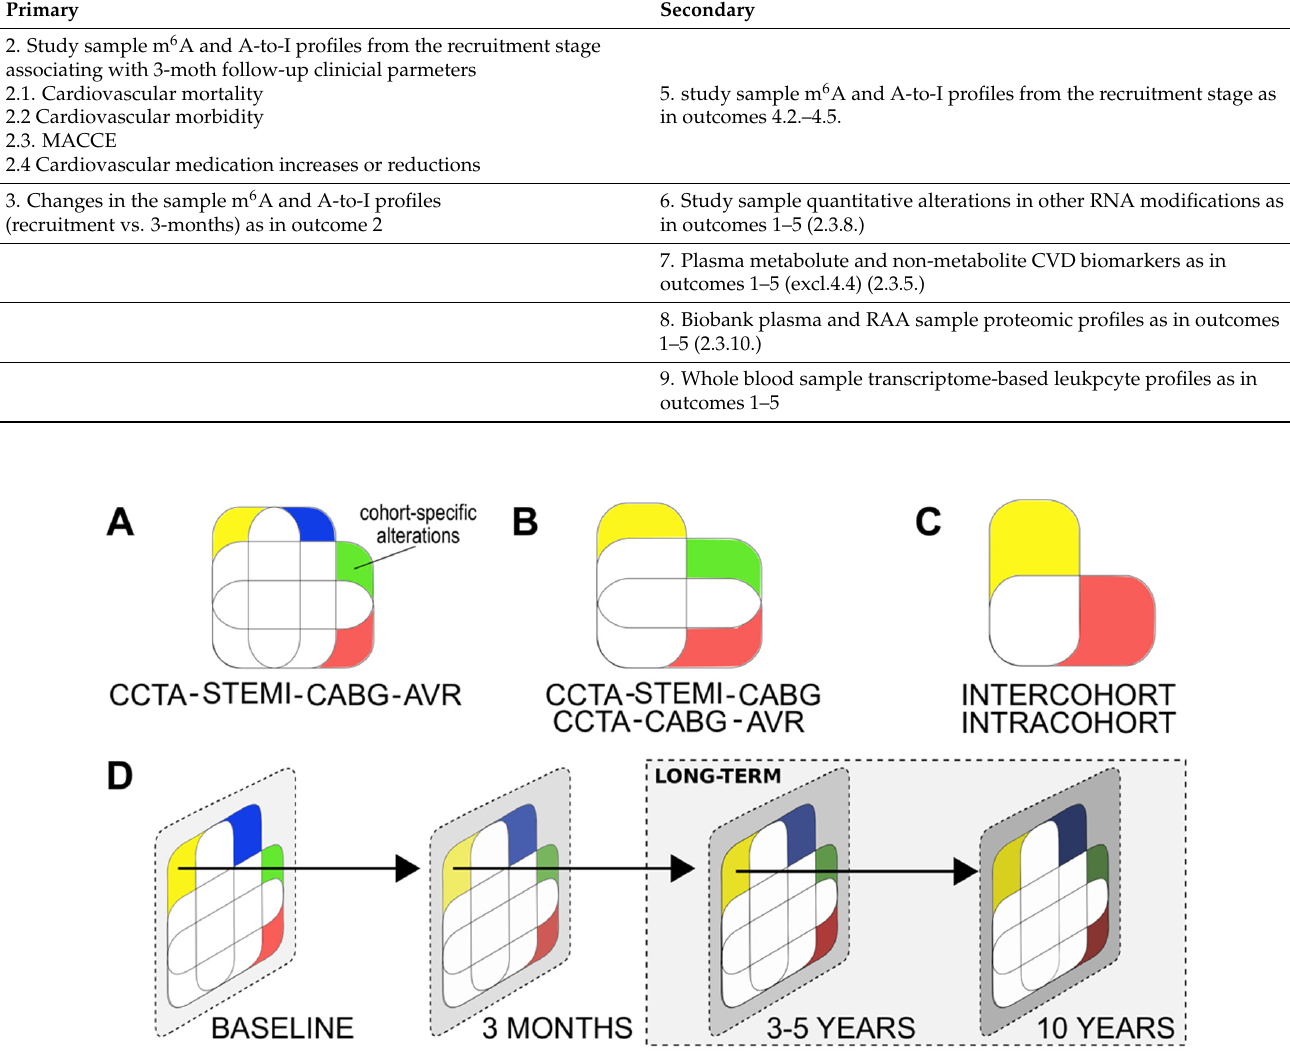
Figure 5. Principal study cohort comparisons in the IHD-EPITRAN study. Referred outcomes are listed in Table 3 ( A ). Venn diagram-based illustration of the preferred four-partite approach, due to its highest degree of adjustments, to acquire inter-cohort comparison-based outcomes. ( B ). Three-partite comparison scheme to enable comparisons even in the possible case of delay in one cohort recruitment, which is also the case with ( C ) depicting pairwise comparisons with lest adjustments for inter-cohort outcomes. Intracohort outcomes are achieved via pairwise prospective comparisons. ( D ). Timeline for the prospective outcome comparisons. Long-term follow-up of the study cohorts I-IV could provide dimensions of detecting incident and IHD exacerbations (Section 2.6 and Discussion). Abbreviations: AVR , aortic valve replacement cohort III; AVS , aortic valve stenosis; CABG , coronary artery bypass grafting cohort II; CCTA , coronary computed tomography angiogram cohort I; CVD , cardiovascular disease; IHD , ischemic heart disease, MACCE , major adverse cardiovascular and cerebrovascular event; PCI , percutaneous coronary intervention; STEMI, ST-elevation myocardial infarction cohort